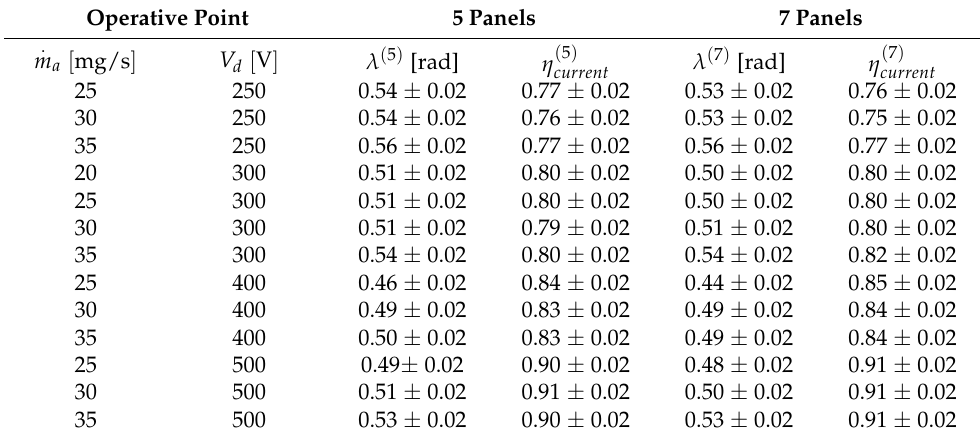
Table A1. λ and η current for the various operative conditions for HT20k M. Operative Point 5 Panels 7 Panels